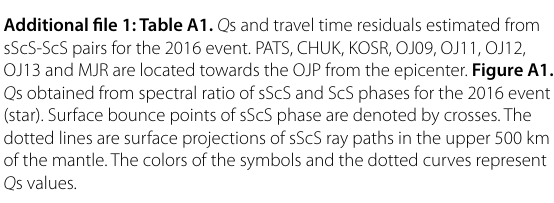
Additional file 1: Table A1. Q s and travel time residuals estimated from sScS-ScS pairs for the 2016 event. PATS, CHUK, KOSR, OJ09, OJ11, OJ12, OJ13 and MJR are located towards the OJP from the epicenter. Figure A1. Q s obtained from spectral ratio of sScS and ScS phases for the 2016 event (star). Surface bounce points of sScS phase are denoted by crosses. The dotted lines are surface projections of sScS ray paths in the upper 500 km of the mantle. The colors of the symbols and the dotted curves represent Q s